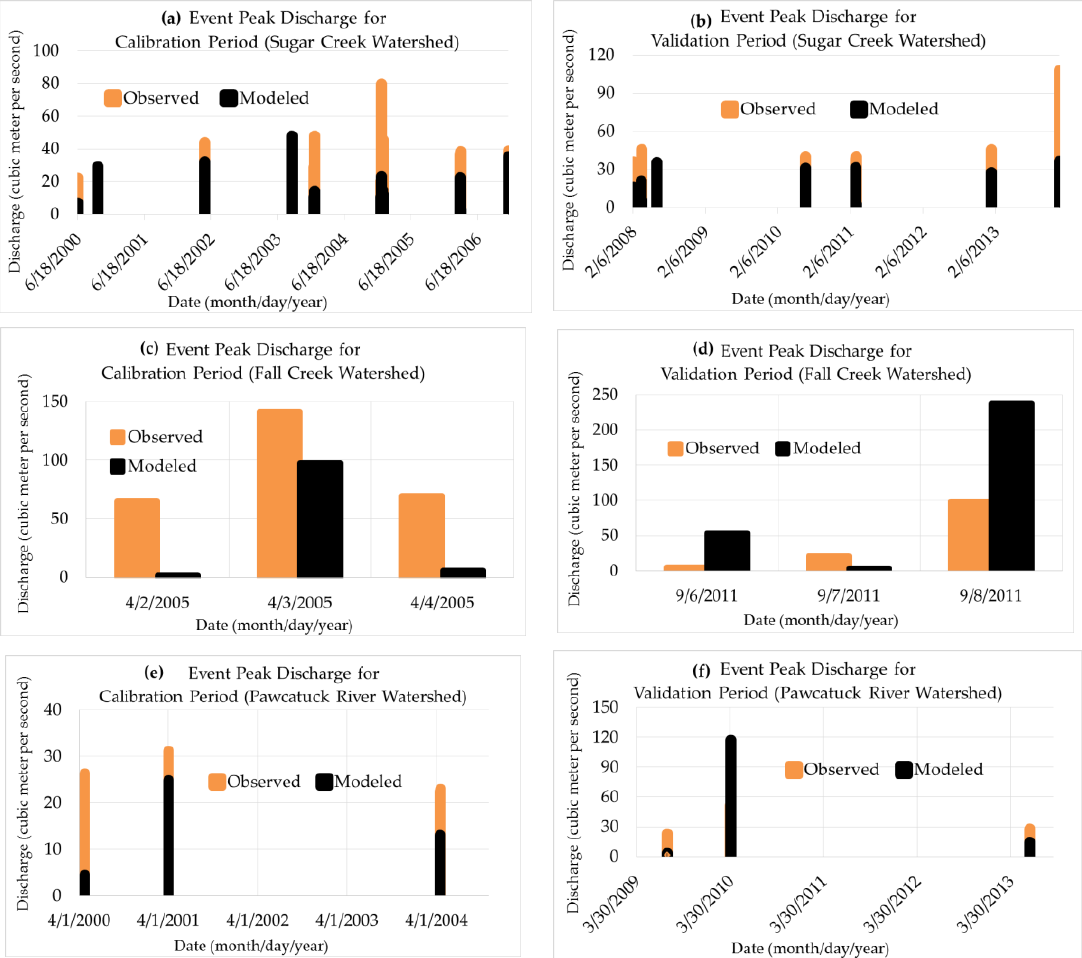
Figure 9. AnnAGNPS model estimation of event peak discharge (cubic meter per second) for: ( a ) calibration period, Sugar Creek Watershed; ( b ) validation period, Sugar Creek Watershed; ( c ) calibration period, Fall Creek Watershed; ( d ) validation period, Fall Creek Watershed; ( e ) calibration period, Pawcatuck River Watershed; ( f ) validation period, Pawcatuck River Watershed.